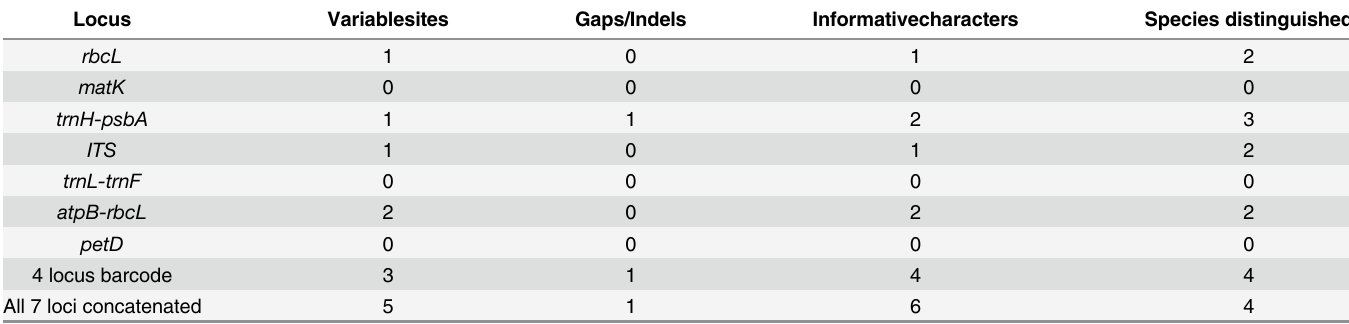
Table 3. Summary of informative characters across all species for each locus sequenced and the number of species they distinguished.